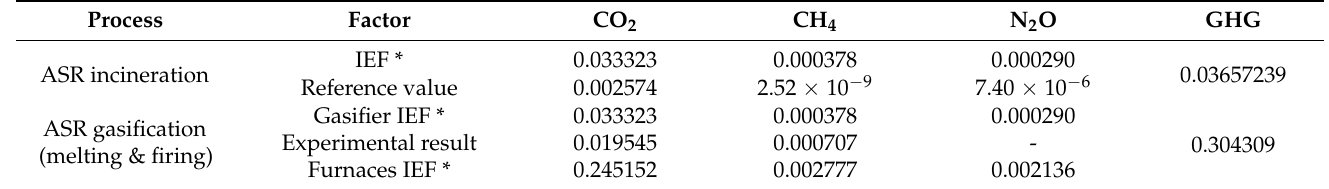
Table 10. Results of GHG Emission for ASR Incineration and ASR Gasification. Unit: ton/ton. Process